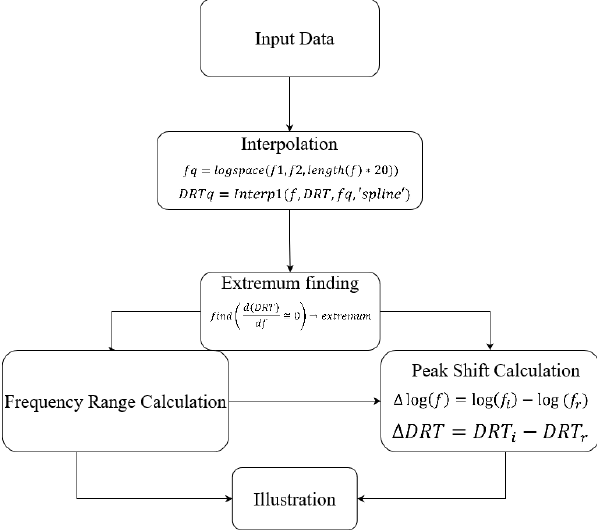
Figure 3. Workflow of the main functions of the tool.